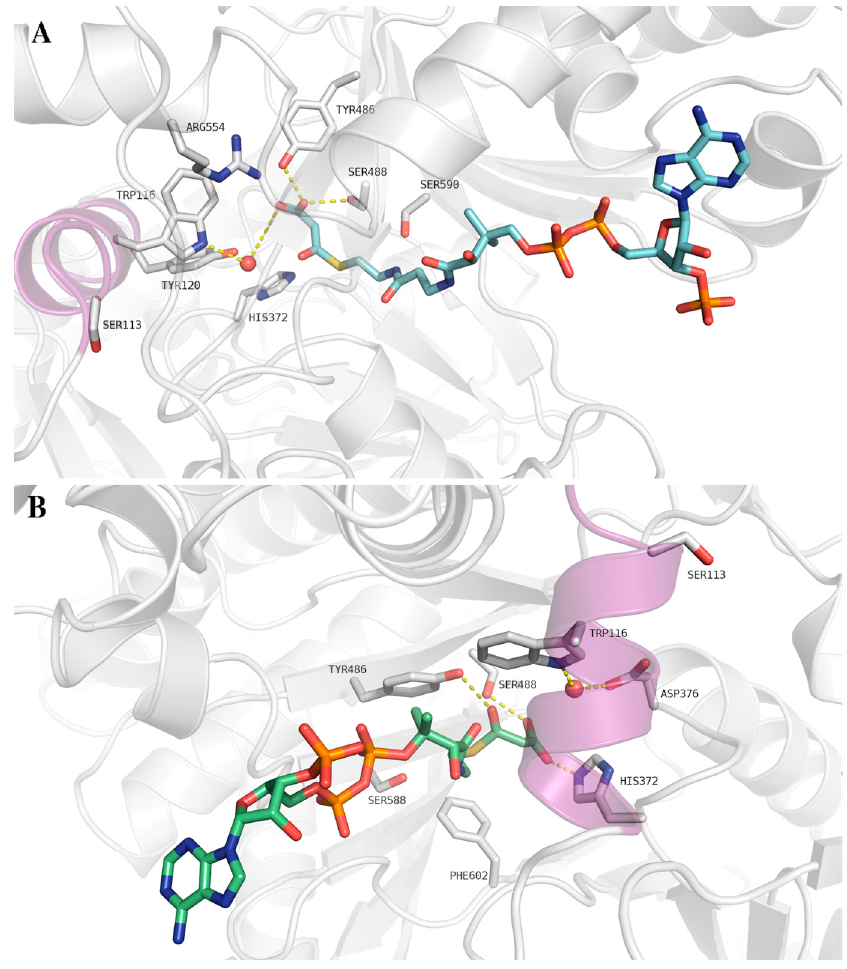
Figure 3. Docking studies of malonyl-CoA with CPT II. ( A ) Interaction of malonyl-CoA (cyan) docked to site I of CPT II; ( B ) Interaction of malonyl-CoA (cyan) docked to site II of CPT II. The conserved water molecule W88 is shown as a red sphere. The α -helix bearing the S113L mutation is shown as a magenta ribbon. Only residues of the catalytic site are shown as white sticks for clarity. Hydrogen bonds are shown as yellow dashed lines.